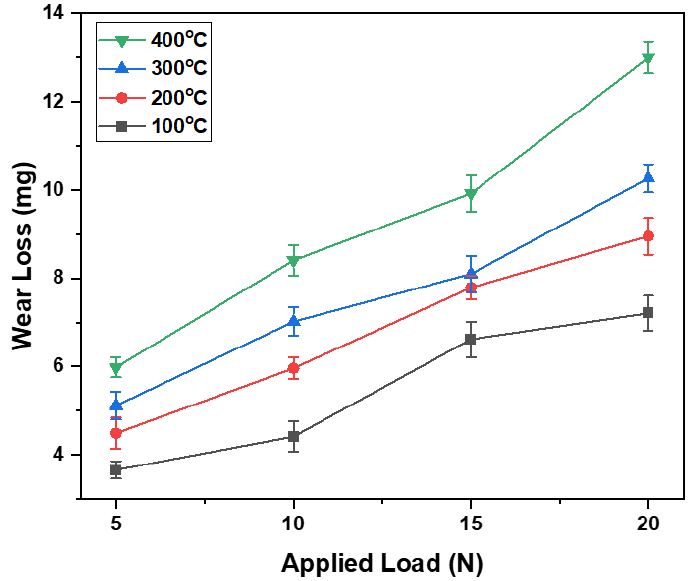
Figure 11. Effect of applied load on wear loss at different temperature for Al–1.0 CNT-1.0Sn specimens with 1.0 wt. % CNT.